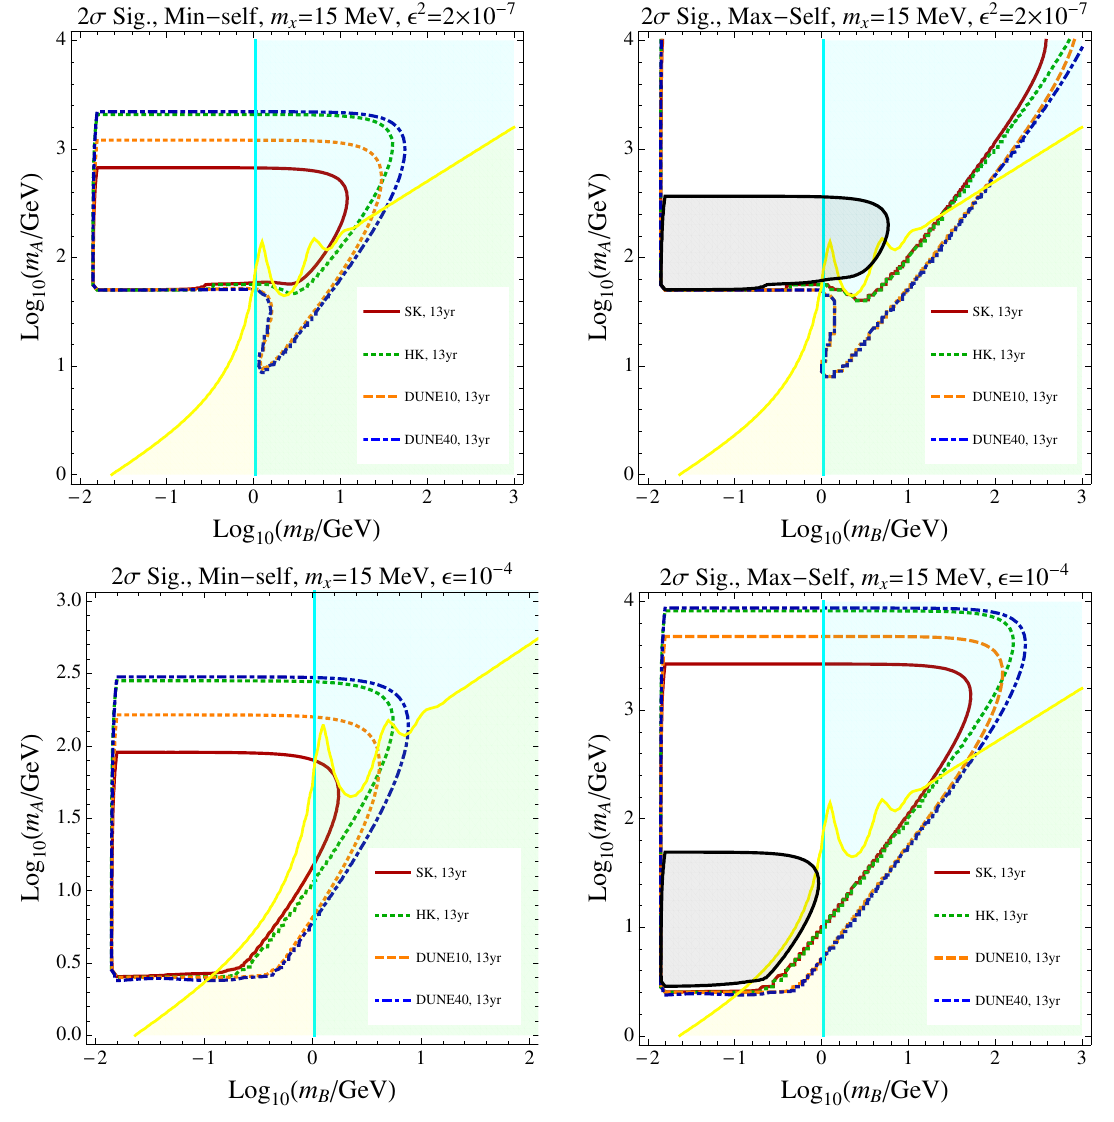
Figure 4 . 2 (cid:27) signi(cid:12)cance of various detectors for (cid:15) 2 = 2 panel for Min (Max) SI in the left-panel (right-panel). All curves assume 13.6 years of running.